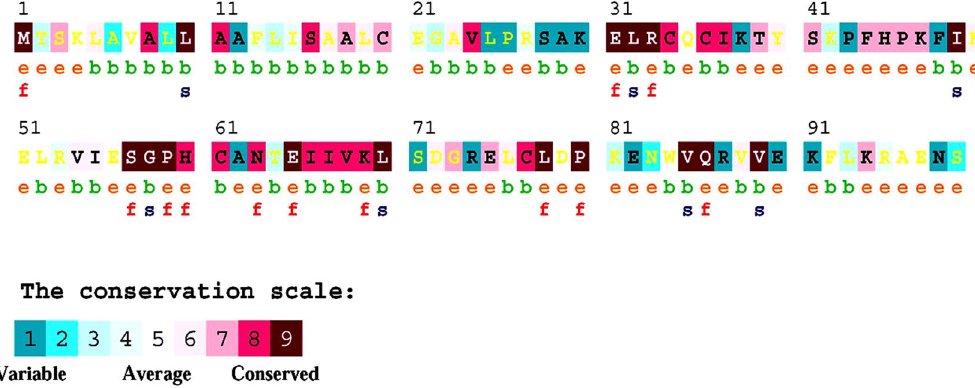
Figure 5. Consurf analysis of human interleukin-8 protein (Uniprot ID: